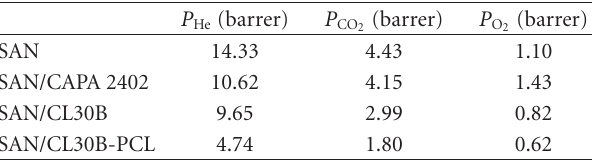
Table 4: Gas transport properties of the films of SAN, SAN/CAPA 2402, SAN/CL30B, SAN/CL30B-PCL with 3 wt% of inorganics. P is the permeability coe ffi